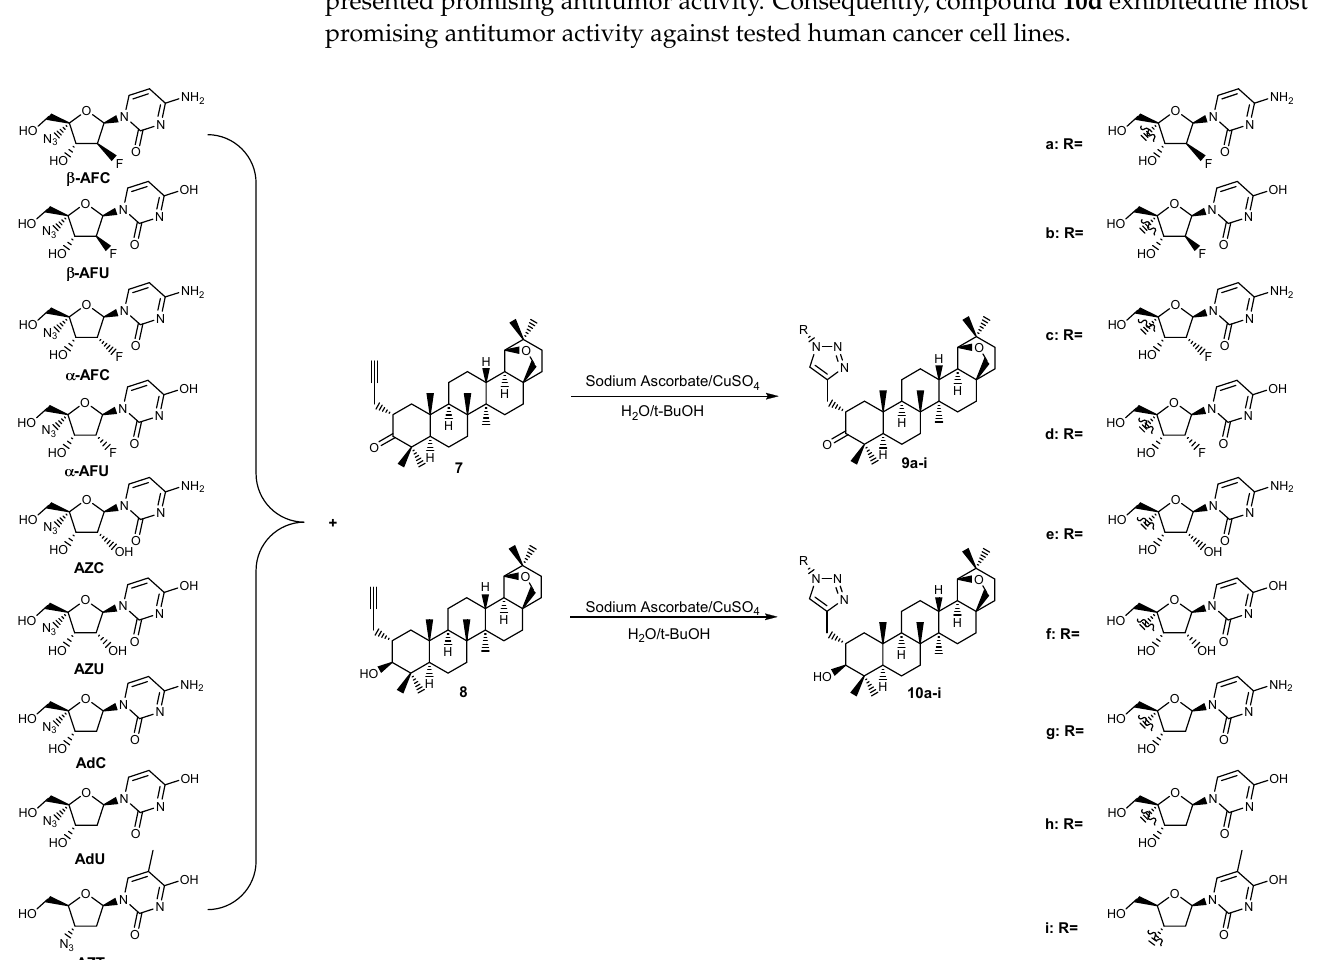
Scheme 2. Synthesis of allobetulin–nucleoside hybrids via click chemistry.